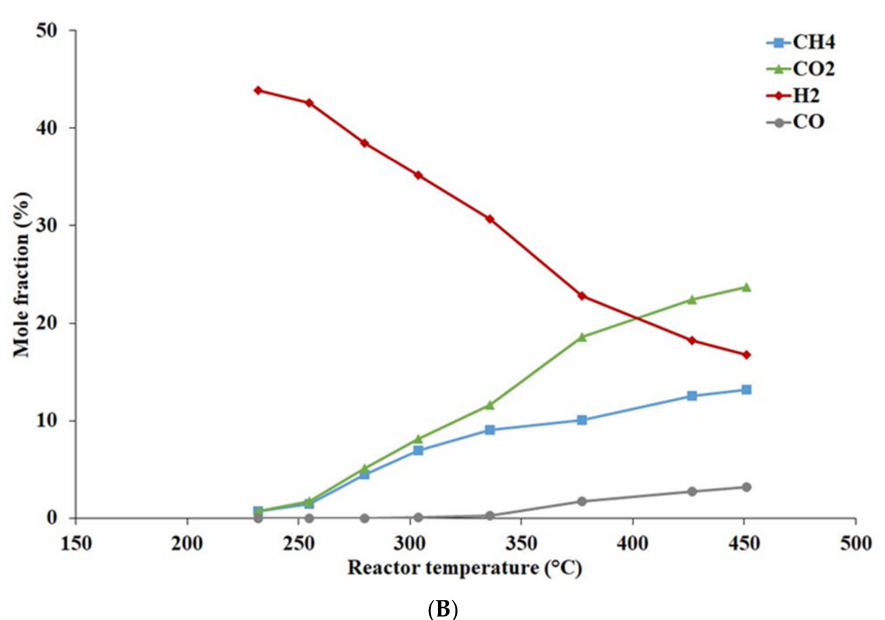
Figure 18. Catalytic tests on Co-based (9.6 wt%) activated catalyst prepared with calcined support with feed gas mixture 1 (50 mole% CO, 50 mole% N 2 ) at pressure 0.5 MPa: ( A )—CO conversion and CO 2 yield; ( B )—composition of the produced